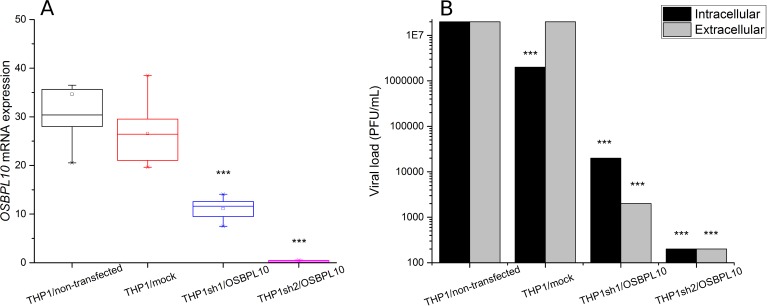
Functional assay of OSBPL10 knockdown and its effect on DENV-replication(A) Box plots for the OSBPL10 mRNA expression in the various THP1 cells (non-transfected and transfected with mock, sh1 and sh2 plasmids). The boxes represent the interquartile range, the little square the mean, the line the median and the whiskers are the 5% and 95% quartiles. The *** symbol indicates that the two-tailed t-test p-values for comparisons between THP1sh1/OSBPL10 and THP1/non-transfected or THP1/mock, as well as for THP1sh2/OSBPL10 and THP1/non-transfected or THP1/mock are significant. (B) Viral load (log10 of PFU/mL), measured intracellularly and extracellularly, in the various THP1 cells (non-transfected and transfected with mock, sh1 and sh2 plasmids) when infected by DENV2. The *** symbol indicates that the two-tailed t-test p-values for pairwise comparisons (THP1sh1/OSBPL10 vs. THP1/non-transfected or THP1/mock, THP1sh2/OSBPL10 vs. THP1/non-transfected or THP1/mock) are significant.